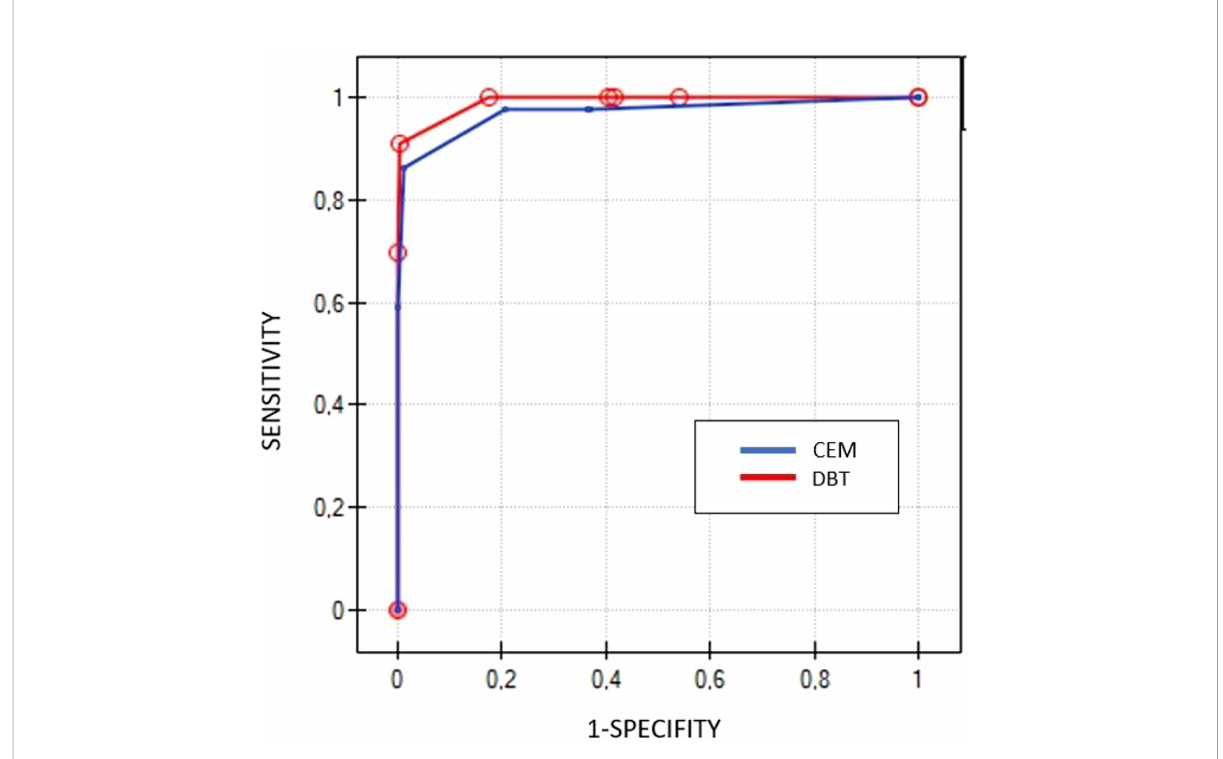
FIGURE 4 Comparison of ROC curves for DBT (red line) and CEM (blue line) based on BIRADS